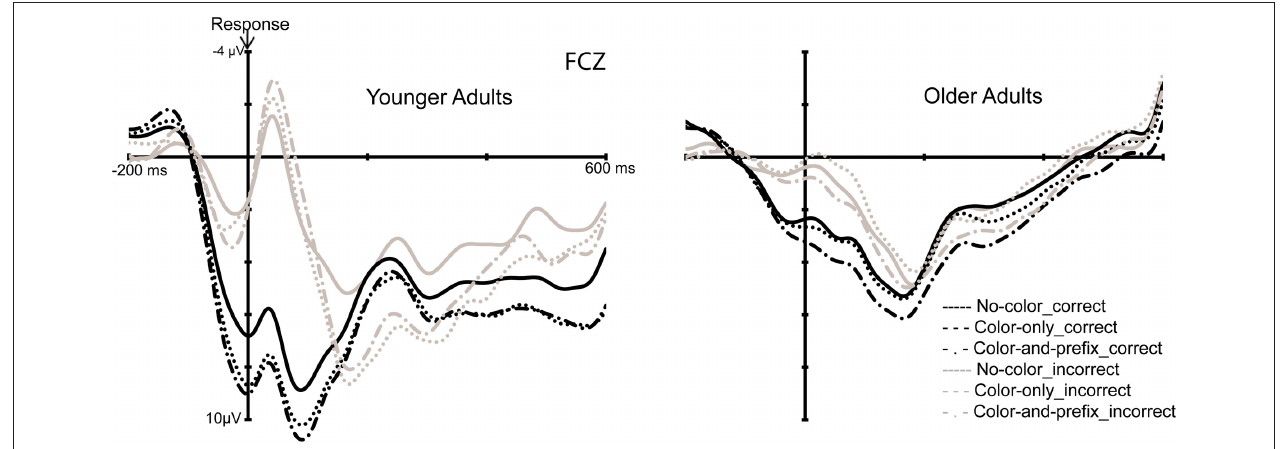
Figure 3 | response‑locked erPs for the young (left) and old (right) age